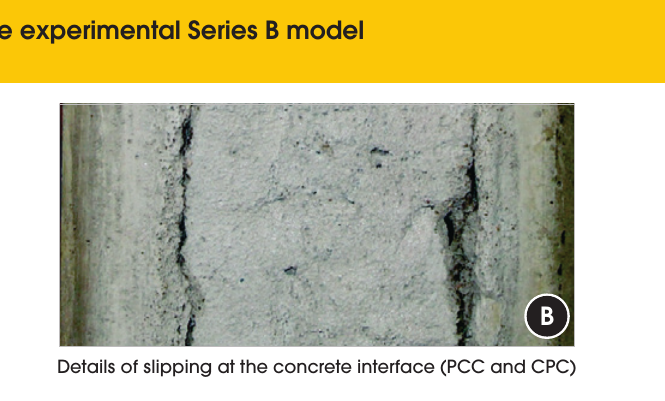
Figure 16 – Rupture of the experimental Series B